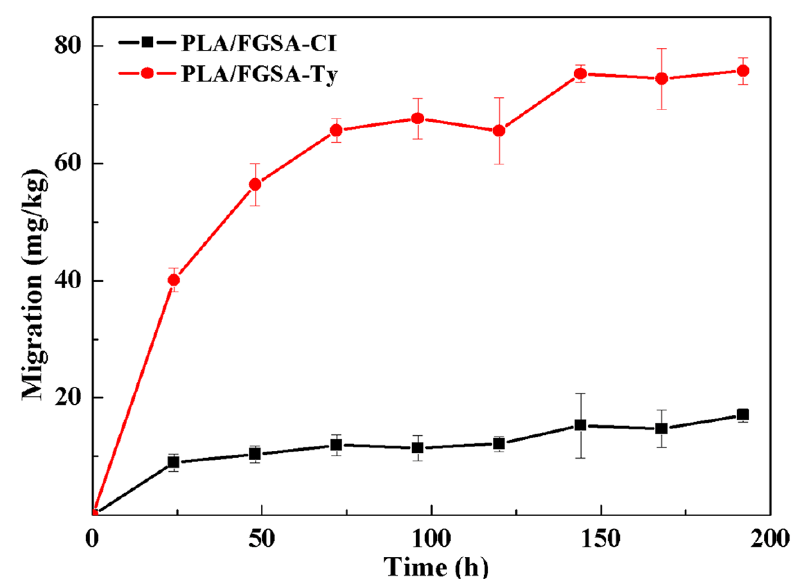
Figure 5. Release of CI and Ty from obtained active bilayer films (PLA/FGSA-CI and PLA/FGSA-Ty) into sea bass fillet.